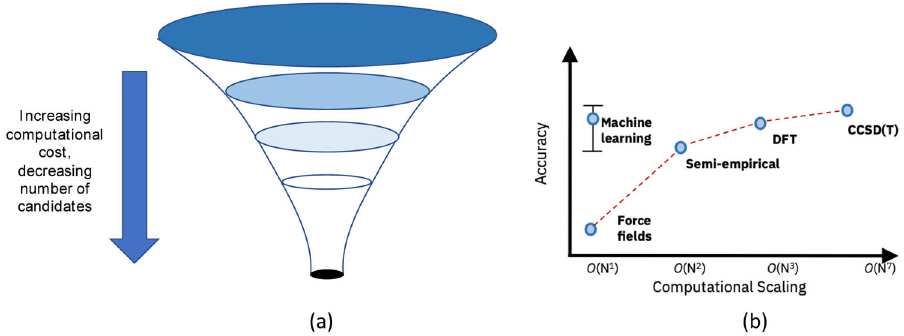
Fig. 4 How computational funnels are commonly used to accelerate the discovery process. a The ‘ traditional ’ computational funnel of high-throughput virtual screening. b Each level in the funnel is affected by the accuracy of screening, and the computational cost to perform the screen. Machine learning has the ability to markedly improve both of these, if the right training data is available.